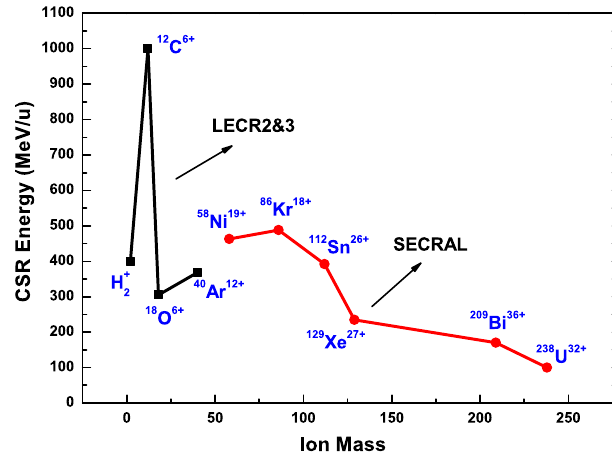
FIG. 30. CSR performance enhancement by SECRAL com- pared with the normal conducting ECR ion sources